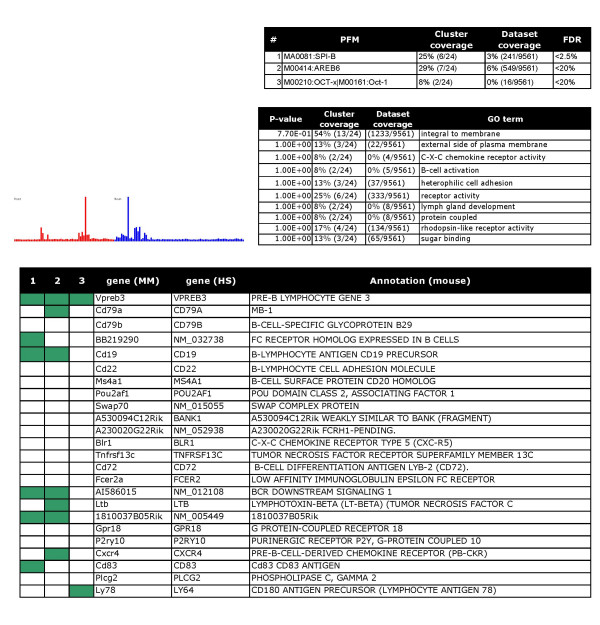
B-lymphocyte differentiation battery: Tables and charts are organized as in figure 2.